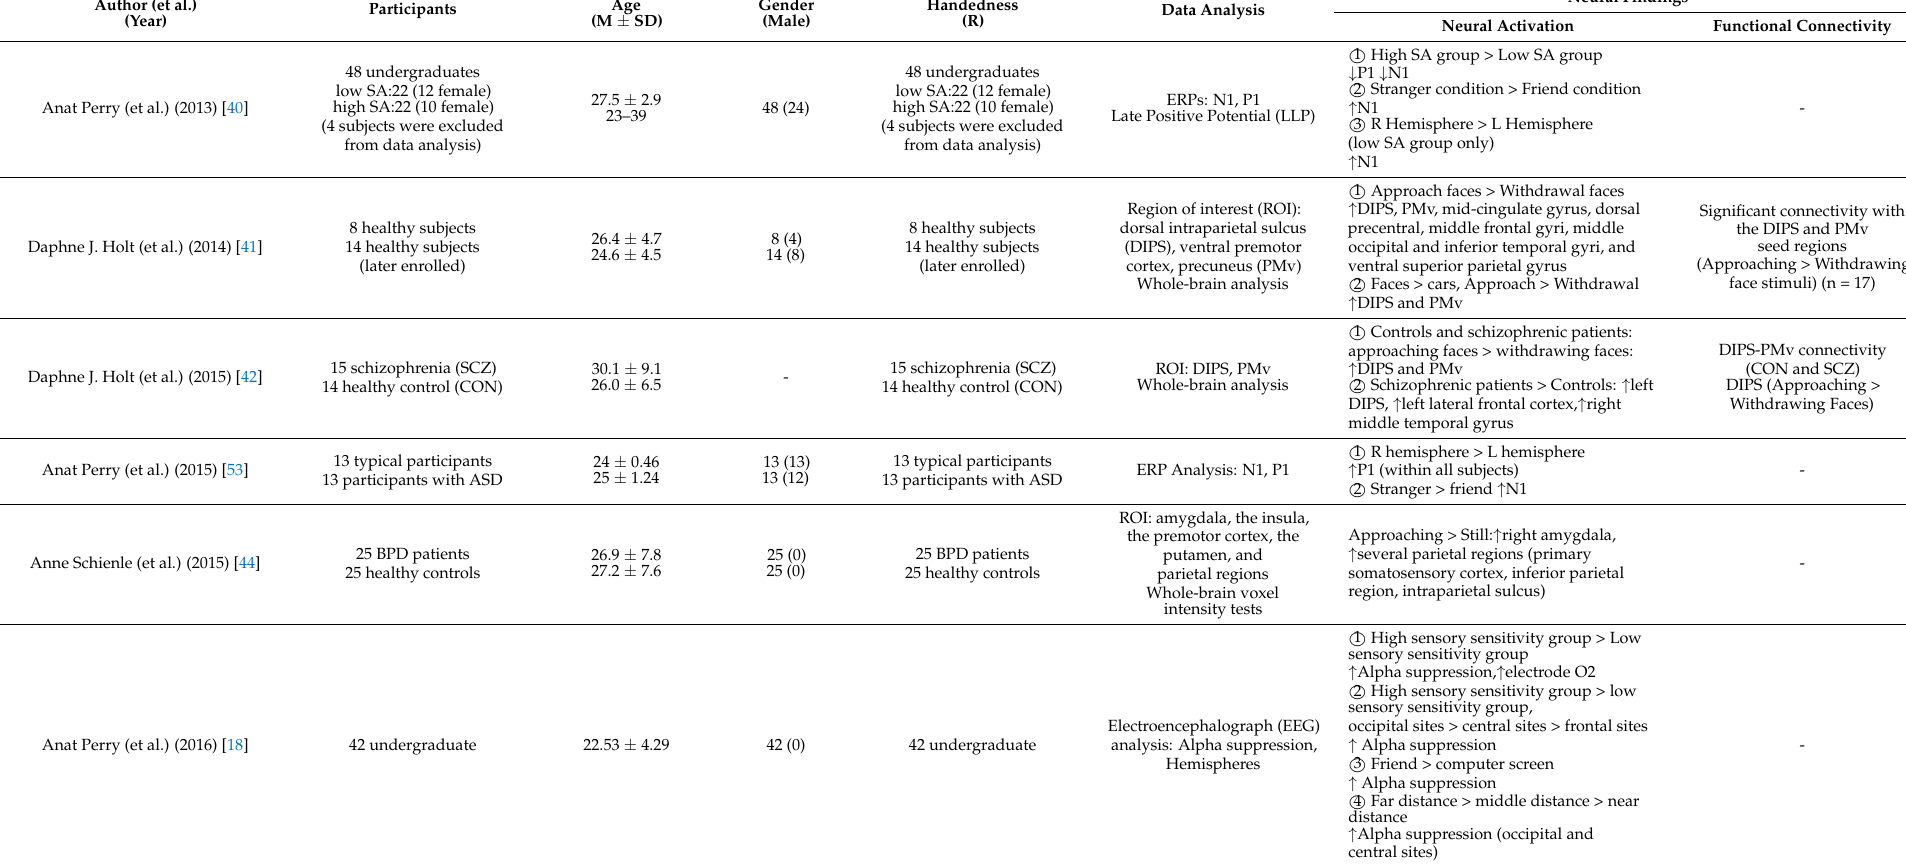
Table 2. Neural activation and functional-connection findings for the included